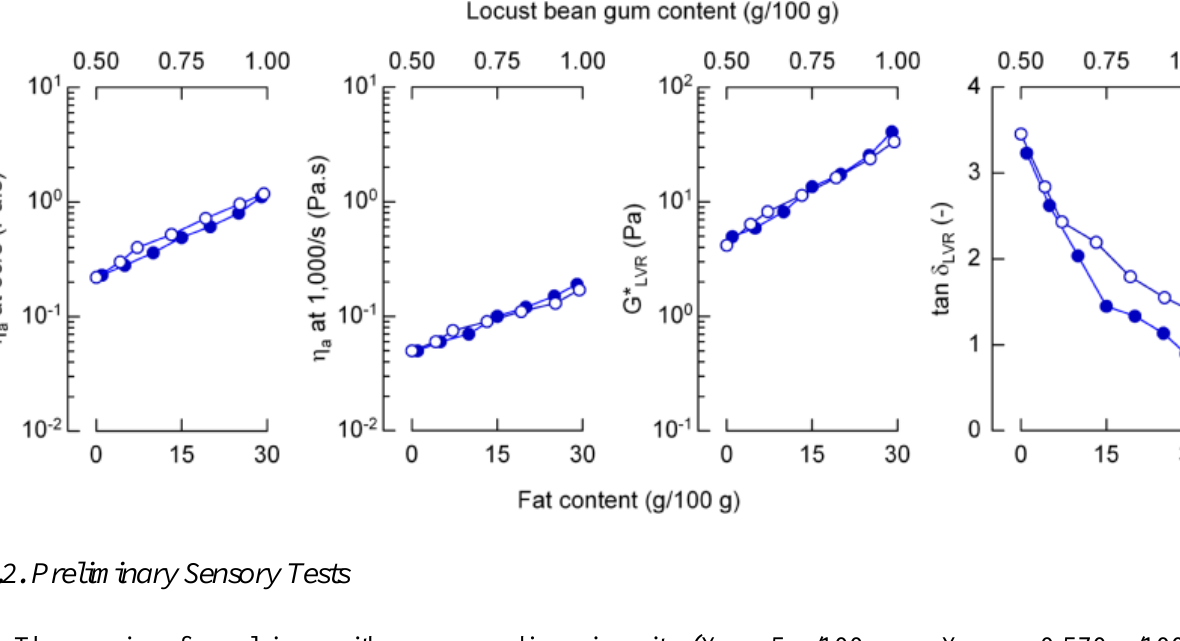
at two shear rates, complex modulus G* a